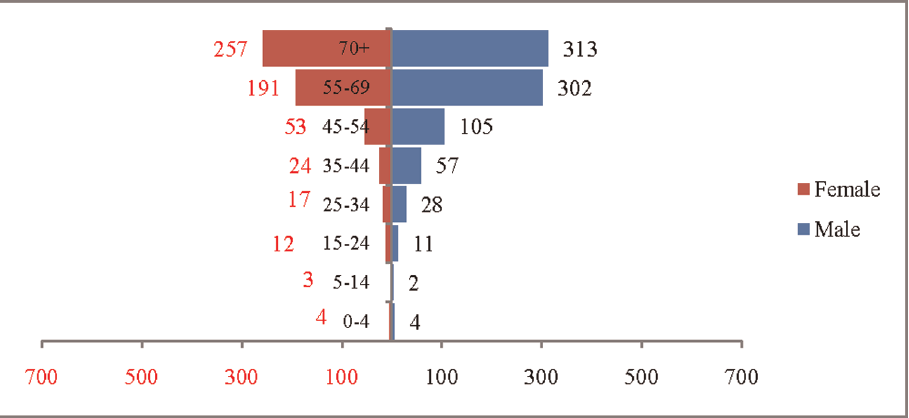
Figure 2. Estimated number of deaths due to CVDs (in 000’s) by age and sex, India, 2004.